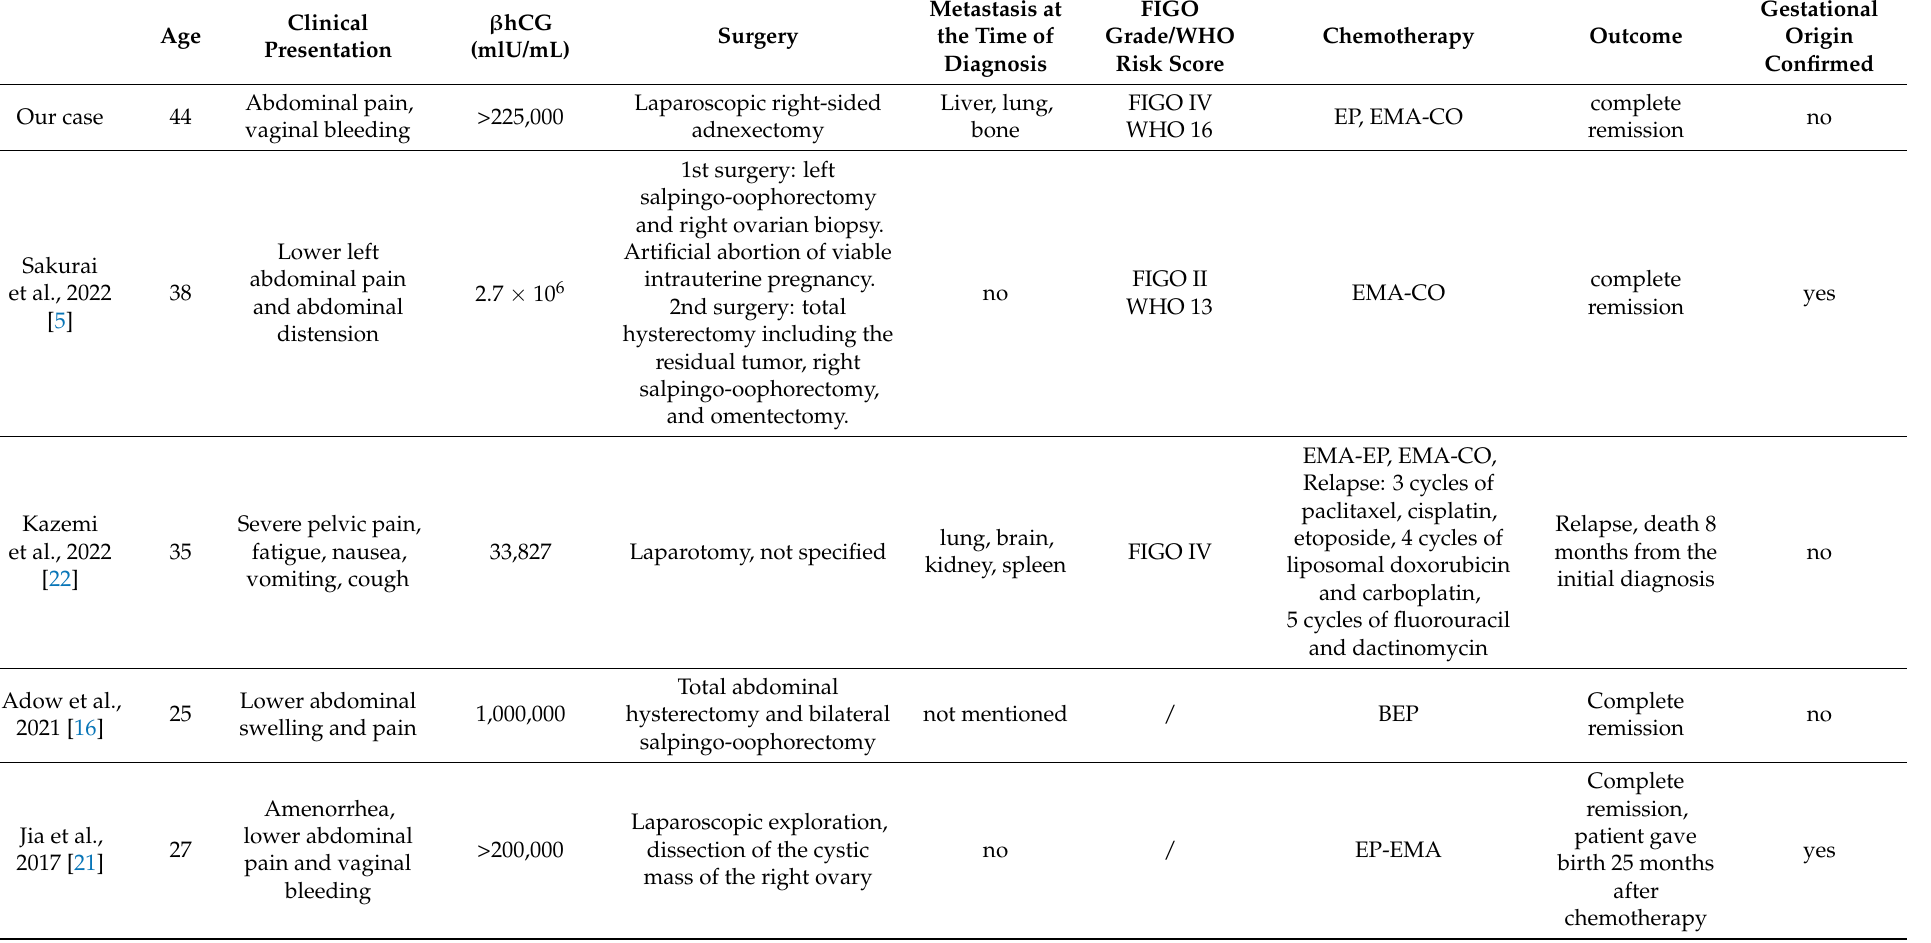
Table 2. Published cases of gestational ovarian